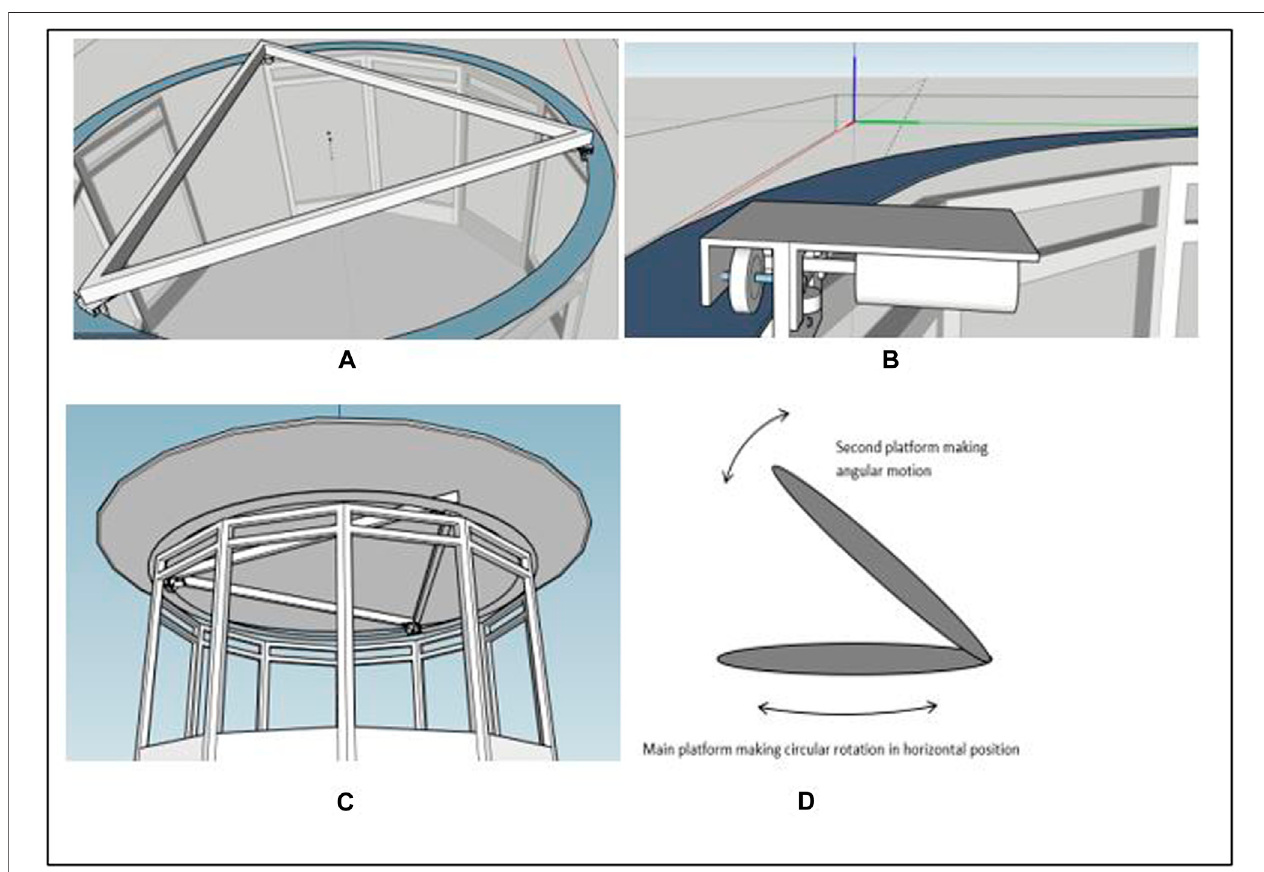
FIGURE 1 | Electro-mechanic structure of RRGS. (A) Disc and Movable triangular carrier. (B) Disc and one of the carrier ’ s motor. (C) Main platform on moving carrier. (D) Main and Second platform.